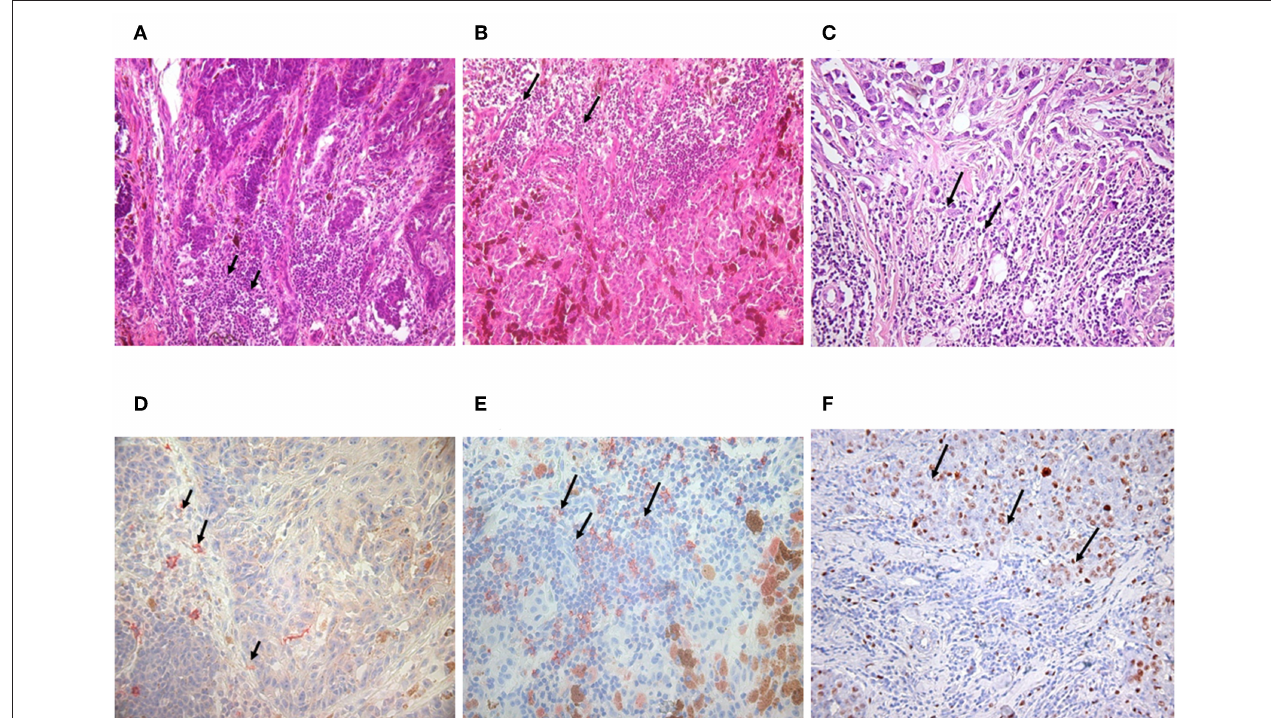
FIGURE 1 | Detection of tumor infiltrating B lymphocytes in malignant melanoma and invasive ductal breast carcinoma. Immunohistology with haematoxilin & eosin staining showed the same abundant immune cell infiltration in nodular (A) and superficial spreading melanoma (B) as in invasive breast carcinoma with medullary features (C) black arrows. B lymphocytes could be defined with CD20 monoclonal antibody, One Step Polymer HRP detection system and AEC substrate in melanoma (D,E) and breast carcinoma by immunohistochemistry (100x). Black arrows are pointing to immune cell infiltration (immunohistology) or CD20 positive B cells labeled in red (immunohistochemistry) (D,E) . Investigations in breast carcinoma postulate that CD5 positive B cells are also present (F) .